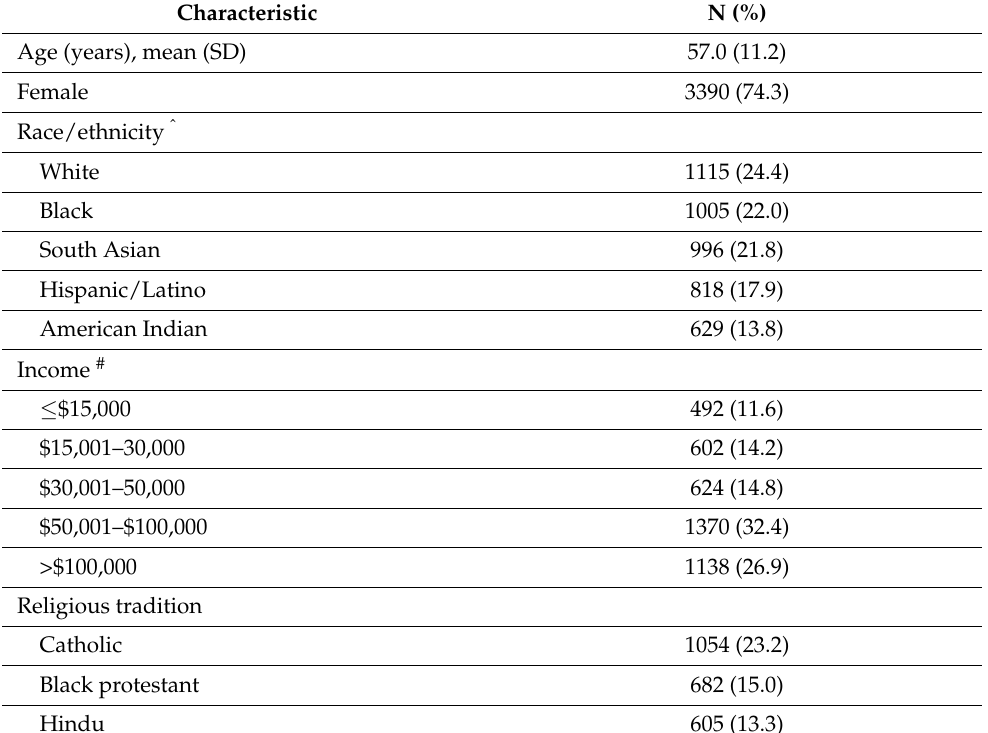
Table 1. Participant Characteristics, N =